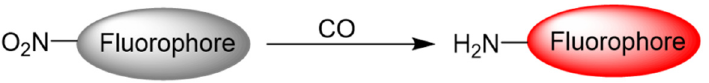
Figure 3. The mechanism diagram of reduction in aromatic nitro to amine reaction.